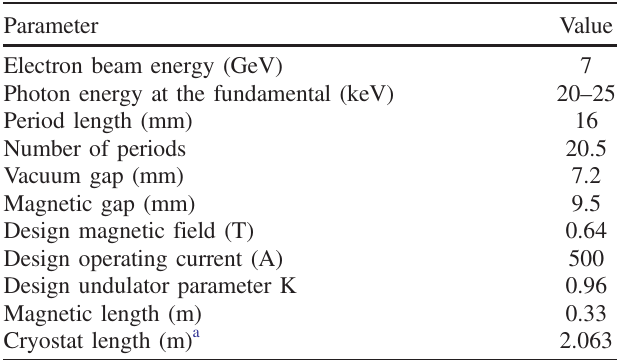
TABLE I. Design parameters of SCU0.